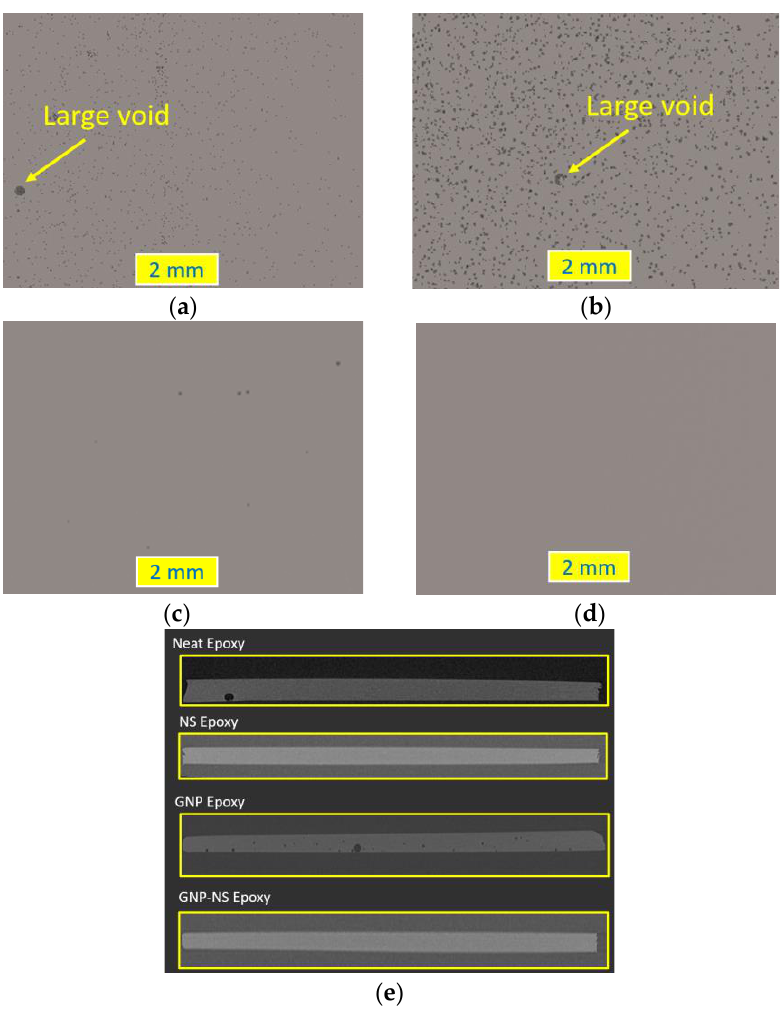
Figure 6. Micro-CT scan images for ( a ) neat epoxy, ( b ) graphene – epoxy, ( c ) nanosilica – epoxy, and ( d ) graphene – nanosilica epoxy, and ( e ) cross-sectional images of each sample.